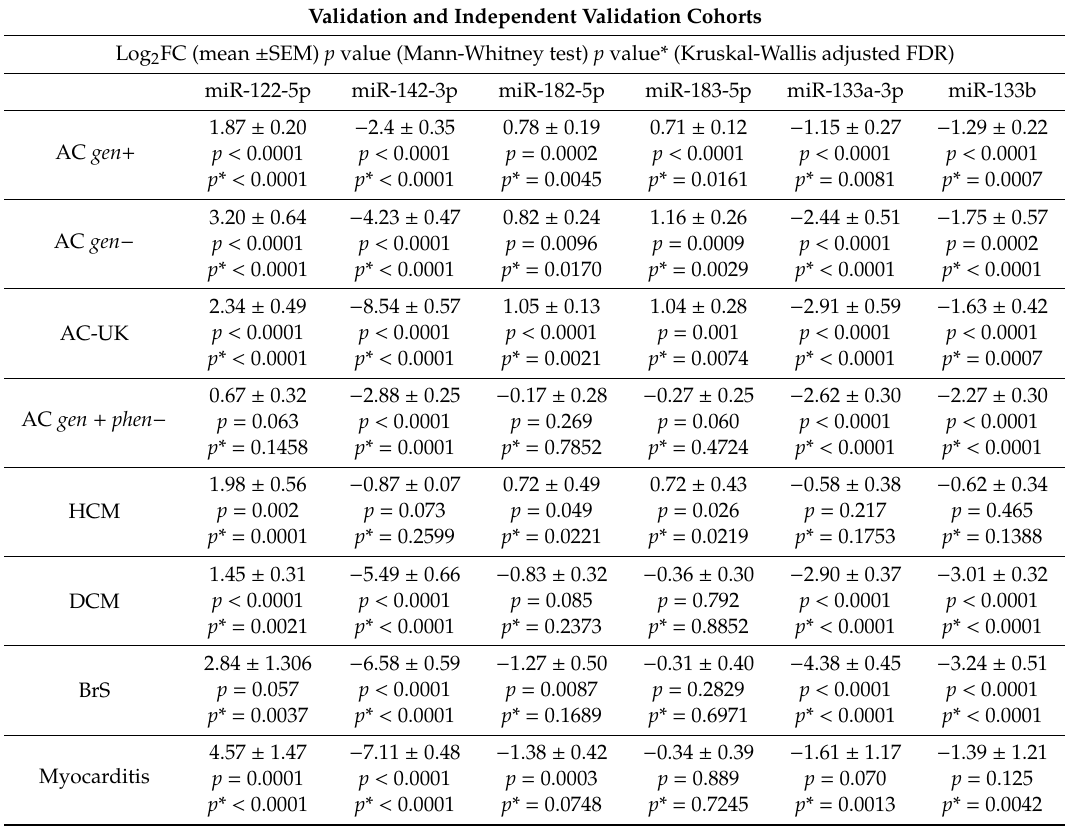
Table 2. Six-miRNA panel expression assessed on validation and independent validation cohorts. Validation and Independent Validation